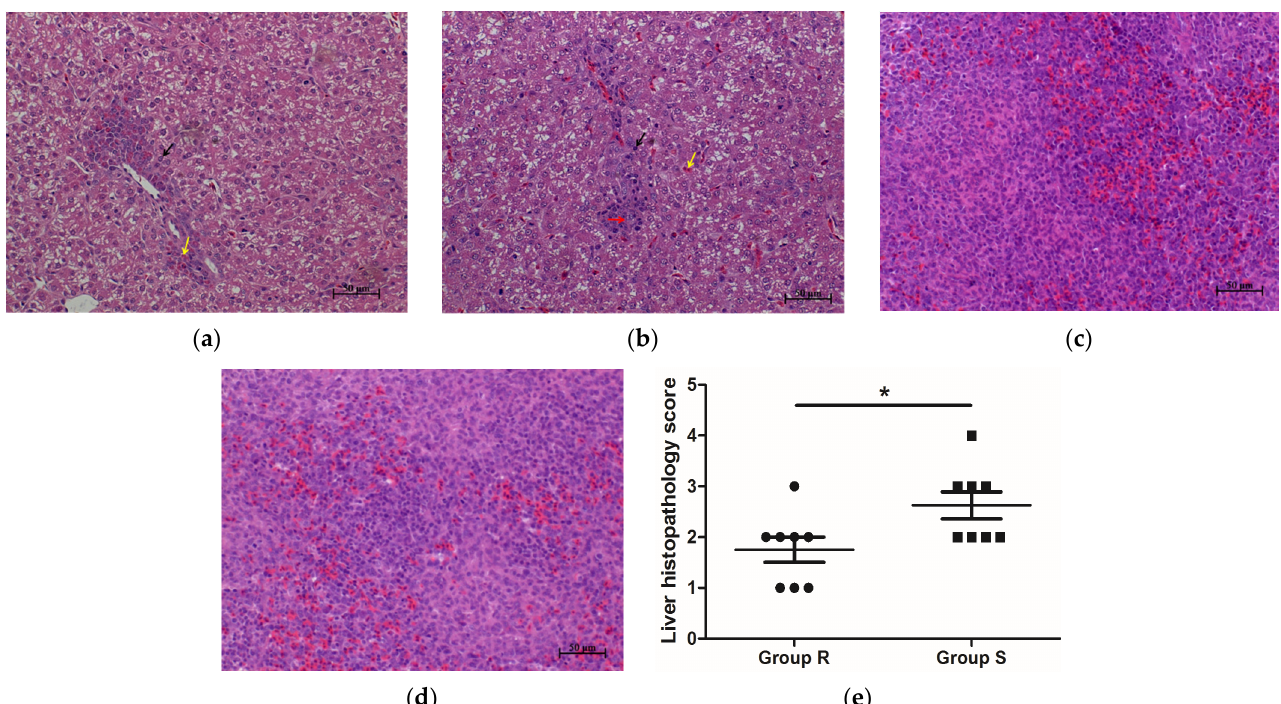
Figure 1. Histopathology of S. enteritidis -resistant and S. enteritidis -susceptible chicks. ( a ) Representative liver histopathol- ogy of S. enteritidis -resistant chicks (HE staining); ( b ) Representative liver histopathology of S. enteritidis -susceptible chicks (HE staining); ( c ) Representative spleen histopathology of S. enteritidis -resistant chicks (HE staining); ( d ) Representative spleen histopathology of S. enteritidis -susceptible chicks (HE staining). Original magnification, ×200. Black arrows indicate the lymphocytes, yellow arrows indicate the heterophilic cells, and red arrows indicate the lymphocyte nodules in liver tissue. Scale bar = 50 μ m. ( e ) Liver histopathology score of S. enteritidis -resistant and -susceptible chicks, n = 8 per group. Result of significance test was p < 0.05 when marked *.